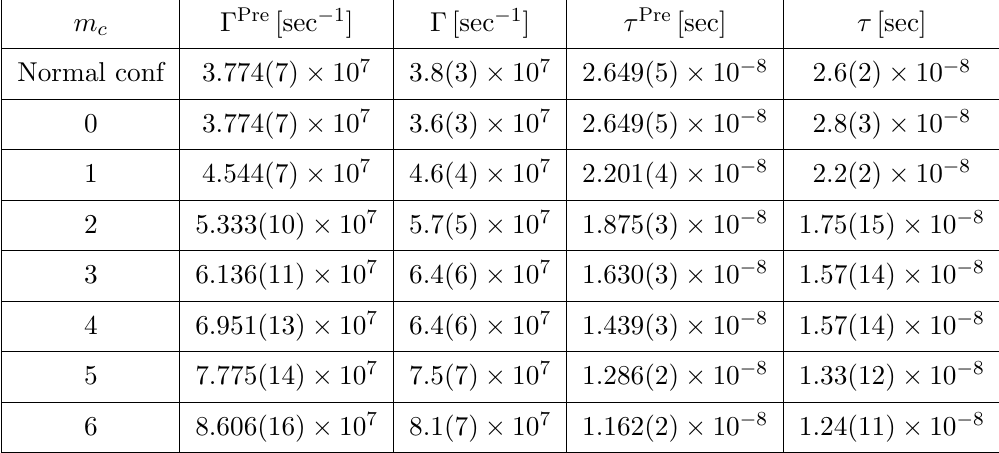
Table 22 . The decay width (cid:0) and lifetime (cid:28) of the charged pion together with their predictions (cid:0) Pre and (cid:28) Pre